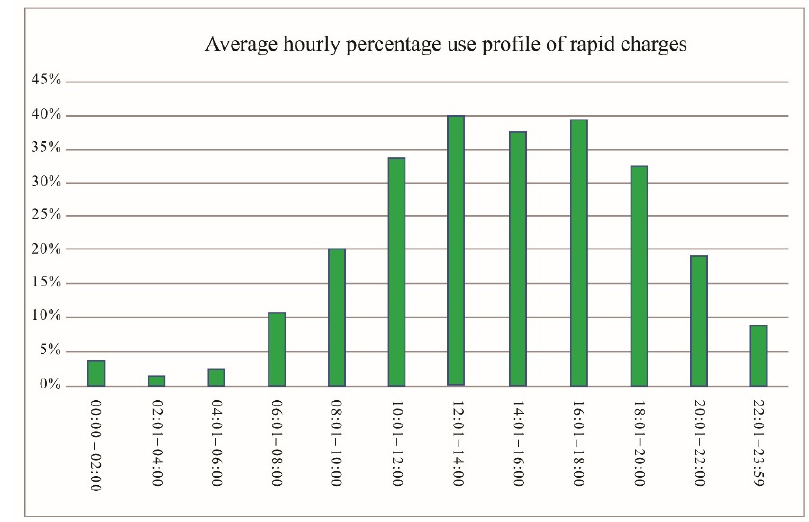
Figure 6. Daily charging characteristics versus time as a percentage [9].